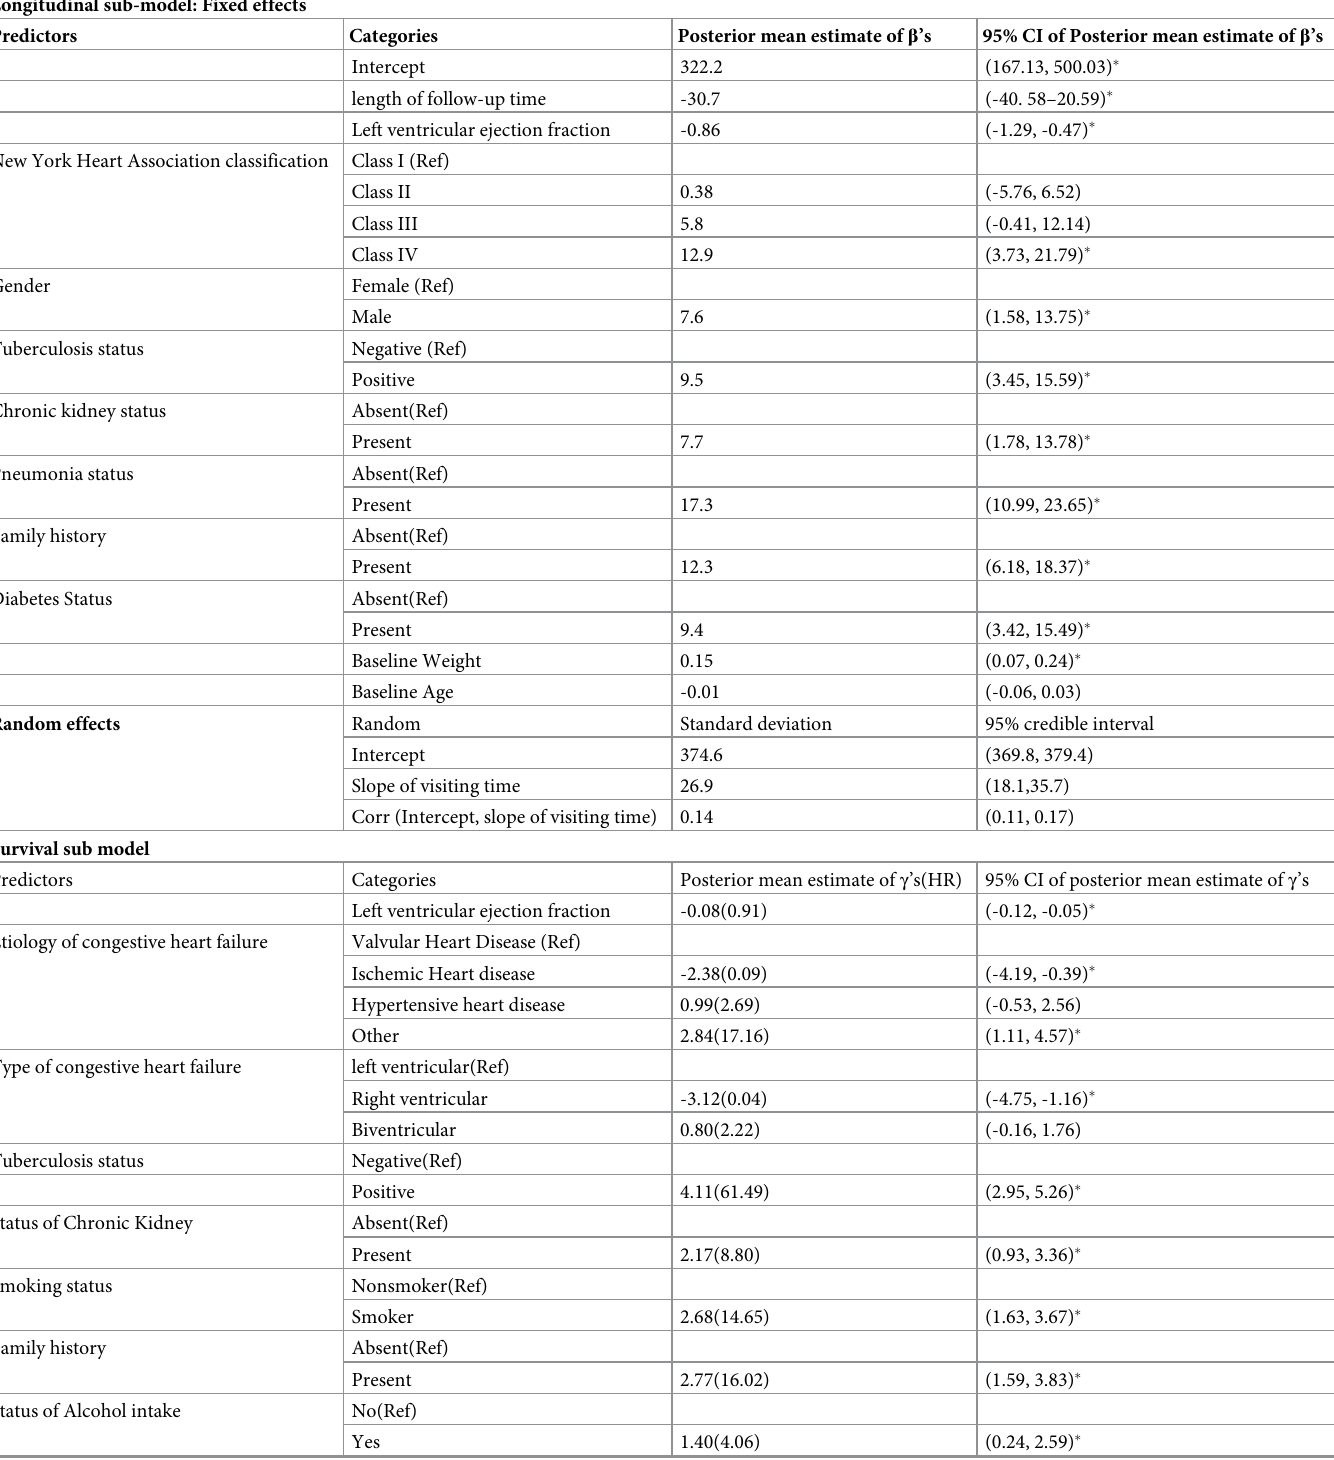
Table 2. Parameter estimation of Bayesian joint model of longitudinal measurement on pulse rate and survival time to death in CHF patients. Longitudinal sub-model: Fixed